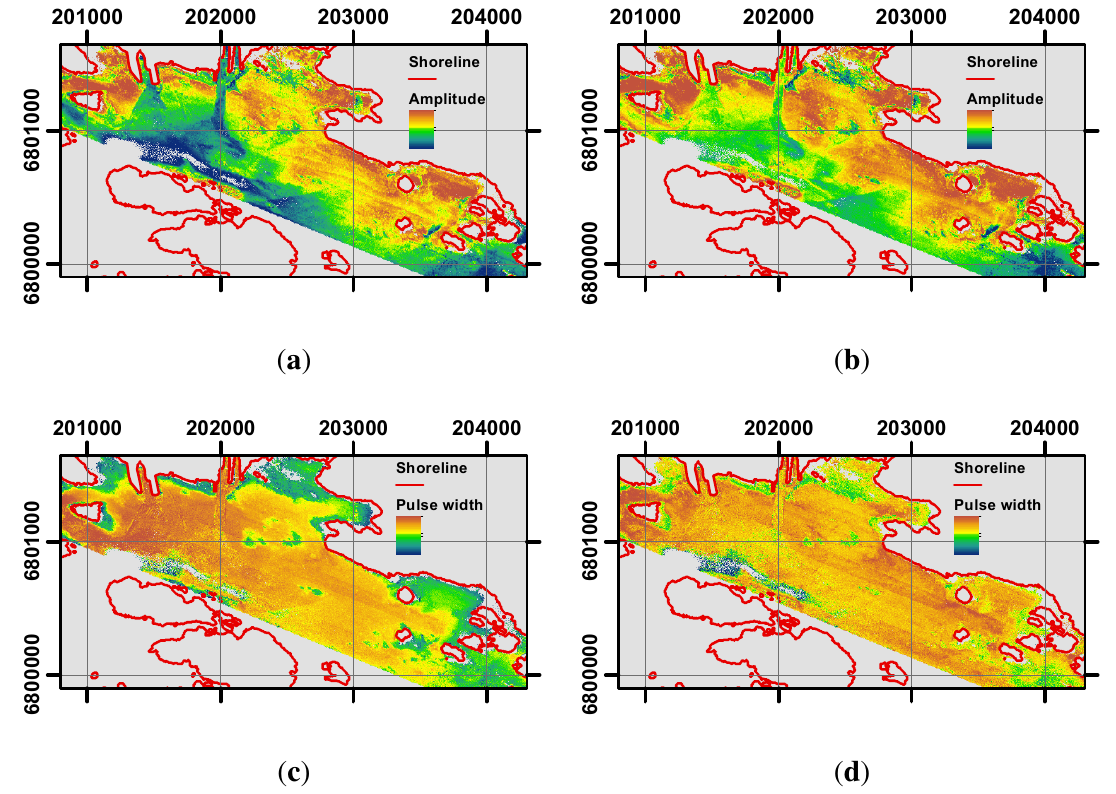
Figure 12. Effects of the feature correction. Note that scales are not directly comparable after the corrections. ( a ): Uncorrected amplitude; ( b ): Corrected amplitude; ( c ): Uncorrected pulse width; ( d ): Corrected pulse